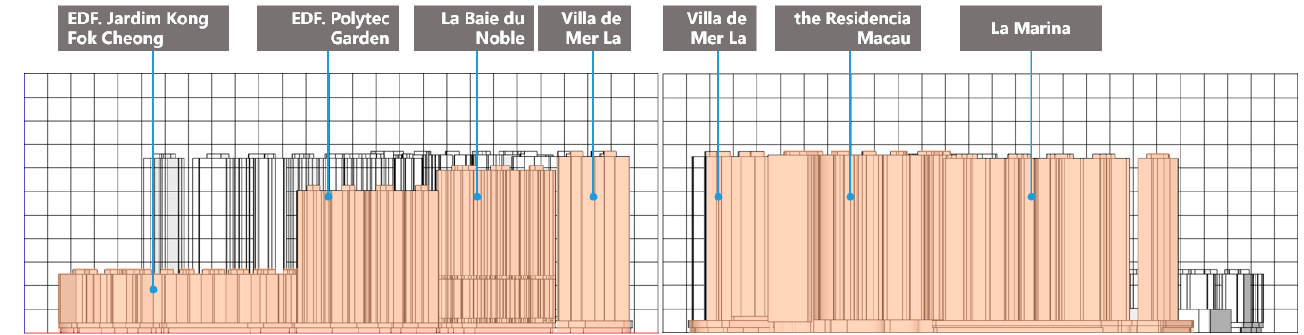
Figure 6. Schematic diagram of the area of the windward side (( left ): south wind direction, ( right ): north wind direction).